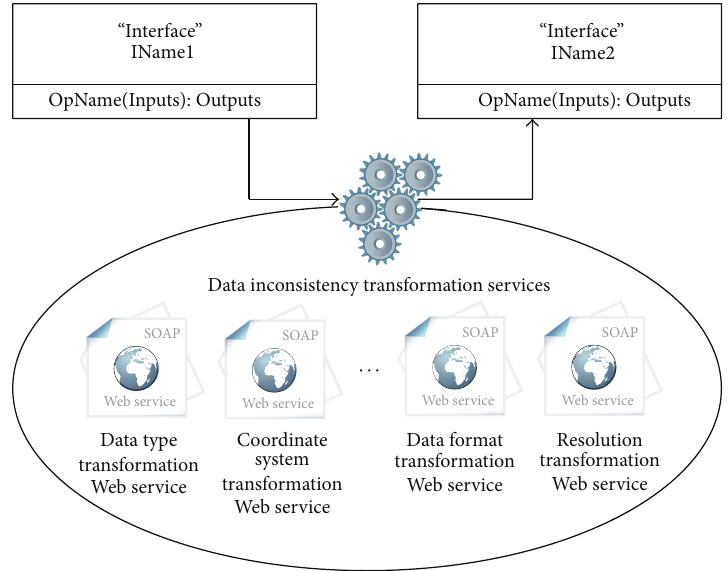
Figure 7: Data inconsistency transformation services.